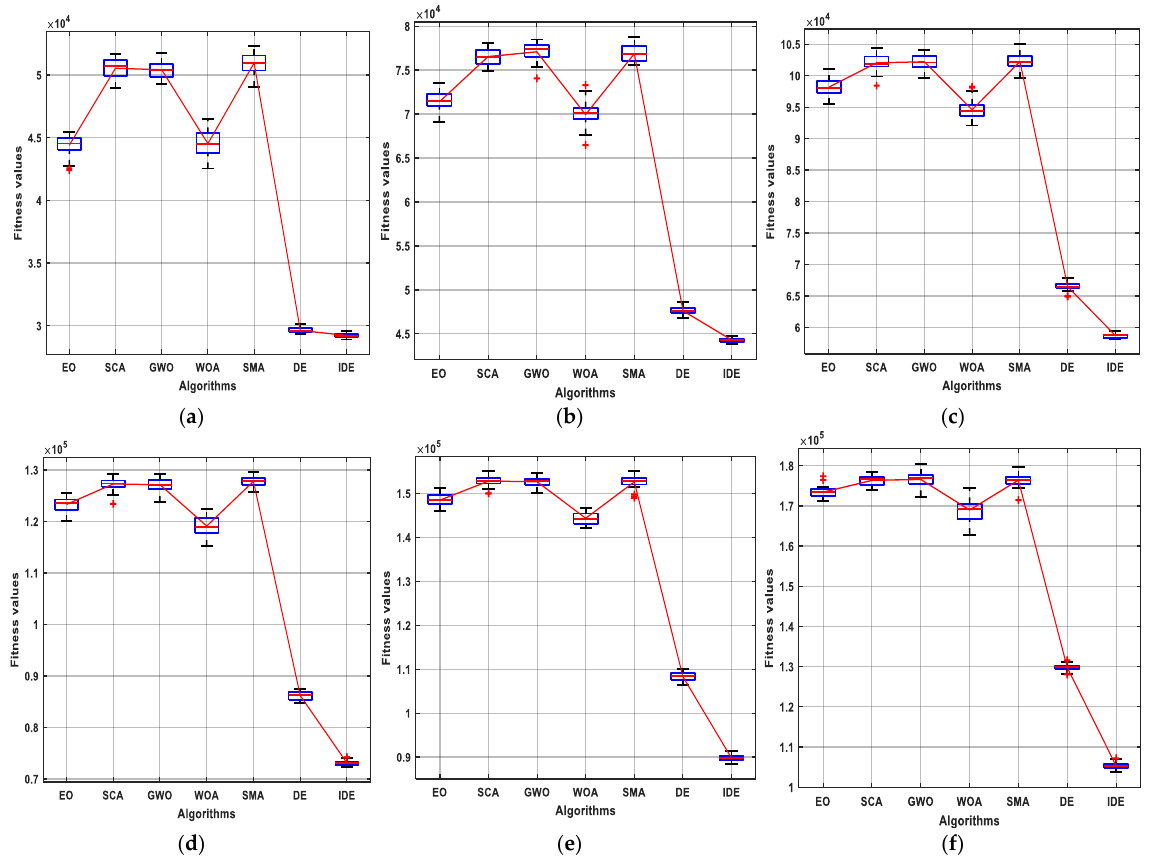
Figure 10. Comparison among algorithms in terms of the Boxplot: ( a ) Comparison for the task size of 200; ( b ) Comparison for the task size of 300; ( c ) Comparison for the task size of 400; ( d ) Comparison for the task size of 500; ( e ) Comparison for the task size of 600; ( f ) Comparison for the task size of 700.